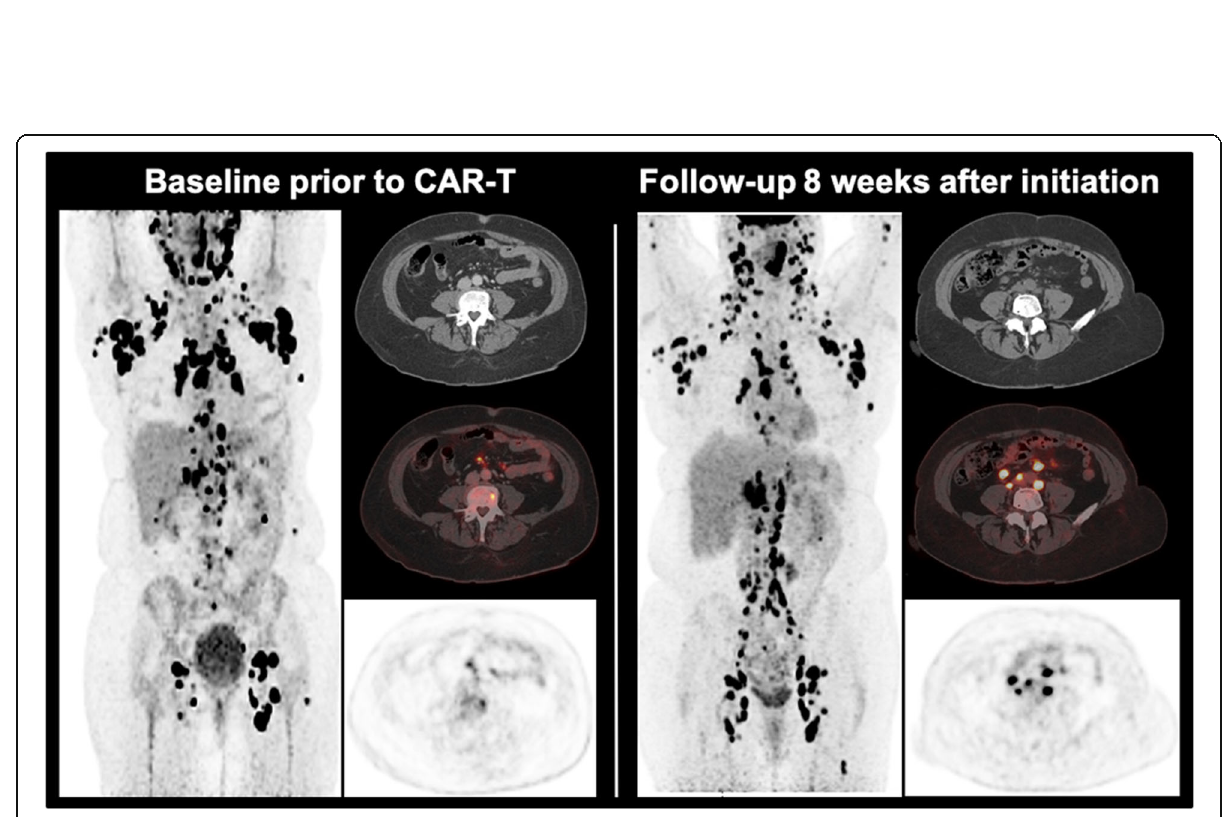
Fig. 2 A patient example with pseudoprogression of diffuse large B cell lymphoma undergoing chimeric antigen receptor T (CAR-T) cell therapy. Eight weeks after reinfusion of CAR-T cells, numerous abdominal lymph nodes with highly increased metabolism occurred, but fully resolved in the further disease course without additional